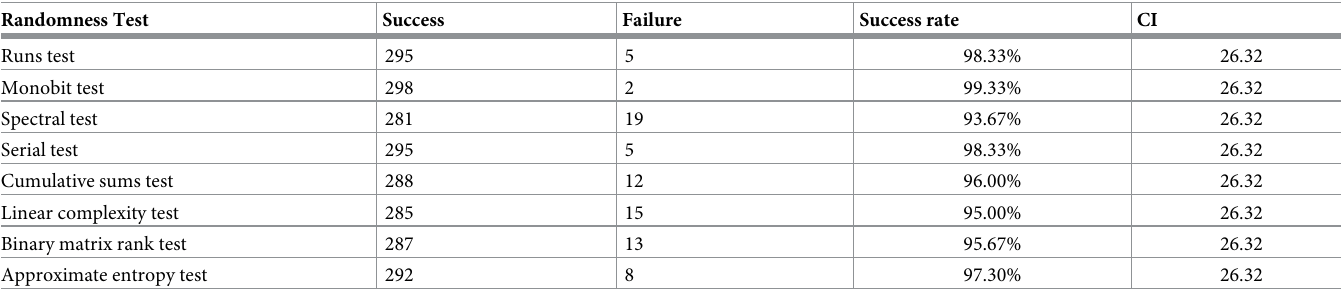
Table 6. Plaintext/Ciphertext correlation test.